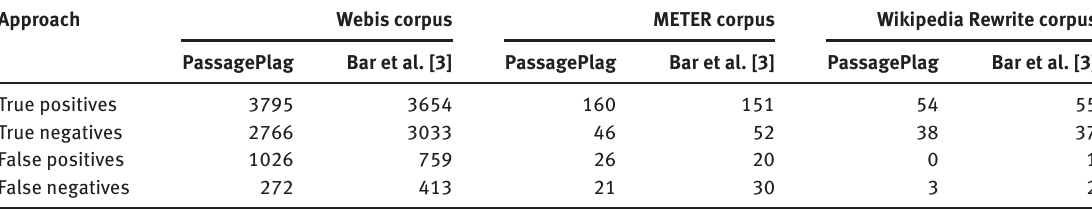
Table 4: Performance Statistics for Various